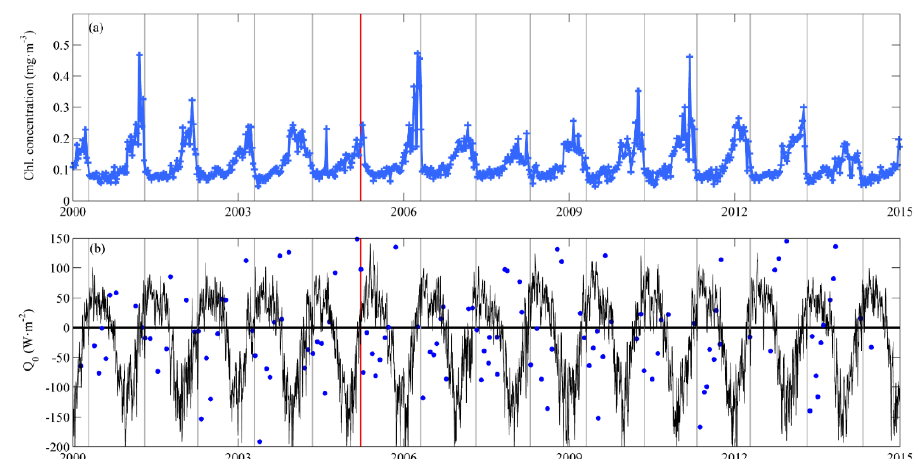
Figure A1. ( a ) Surface chlorophyll concentration from weekly (blue cross line) satellite-derived Chlorophyll a concentration from GlobColour project and (b) net heat flux (Q 0 ) (black line) from the ocean to the atmosphere (negative values imply a heat loss by the ocean) at the location of Bermuda Atlantic Time-series Study (BATS, http://bats.bios.edu/) oceanographic time-series (32.2° N, 64.5° W) in the North Atlantic subtropical gyre. Chlorophyll time-series are obtained as the average weekly time-series within the closest grid to BATS location ± 1.9/2° N and ± 1.9/2° E (NCEP/NCAR spatial resolution is 1.9° × 1.9°). Blue dots in ( b ) show the accumulated heat storage above the MLD (Q strg ) estimated from hydrographic profiles from BATS oceanographic station. It is shown as –Q strg to facilitate the identification of net heat loss events sufficiently negative to remove Q strg above the MLD (Q 0 < −Qstrg). Vertical grey lines show the definitive cessation of convective mixing when the last net heat loss event sufficiently negative to reach the base of the MLD occurs (sufficiently negative to remove Q strg above the MLD) in the different years. In 2005, it is shown by a red vertical line because the definitive cessation of convective mixing does not coincide with a drastic reduction of surface chlorophyll concentration. For the rest of the years, the same relation observed at mid-latitudes of the Eastern North Atlantic is found here. The dates of last convective mixing event vary between the 17th of April and the 8th of May.